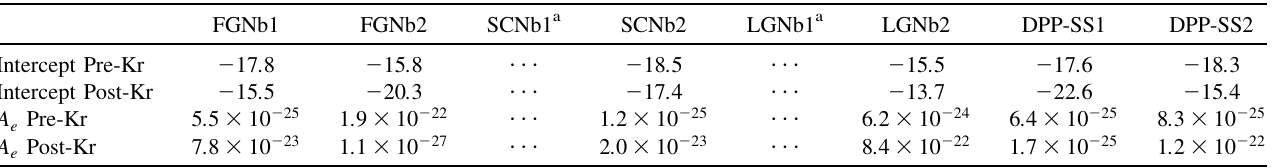
TABLE III. Fowler-Nordheim line-plot intercept values and emission areas, assuming all of the field emission originates from a single